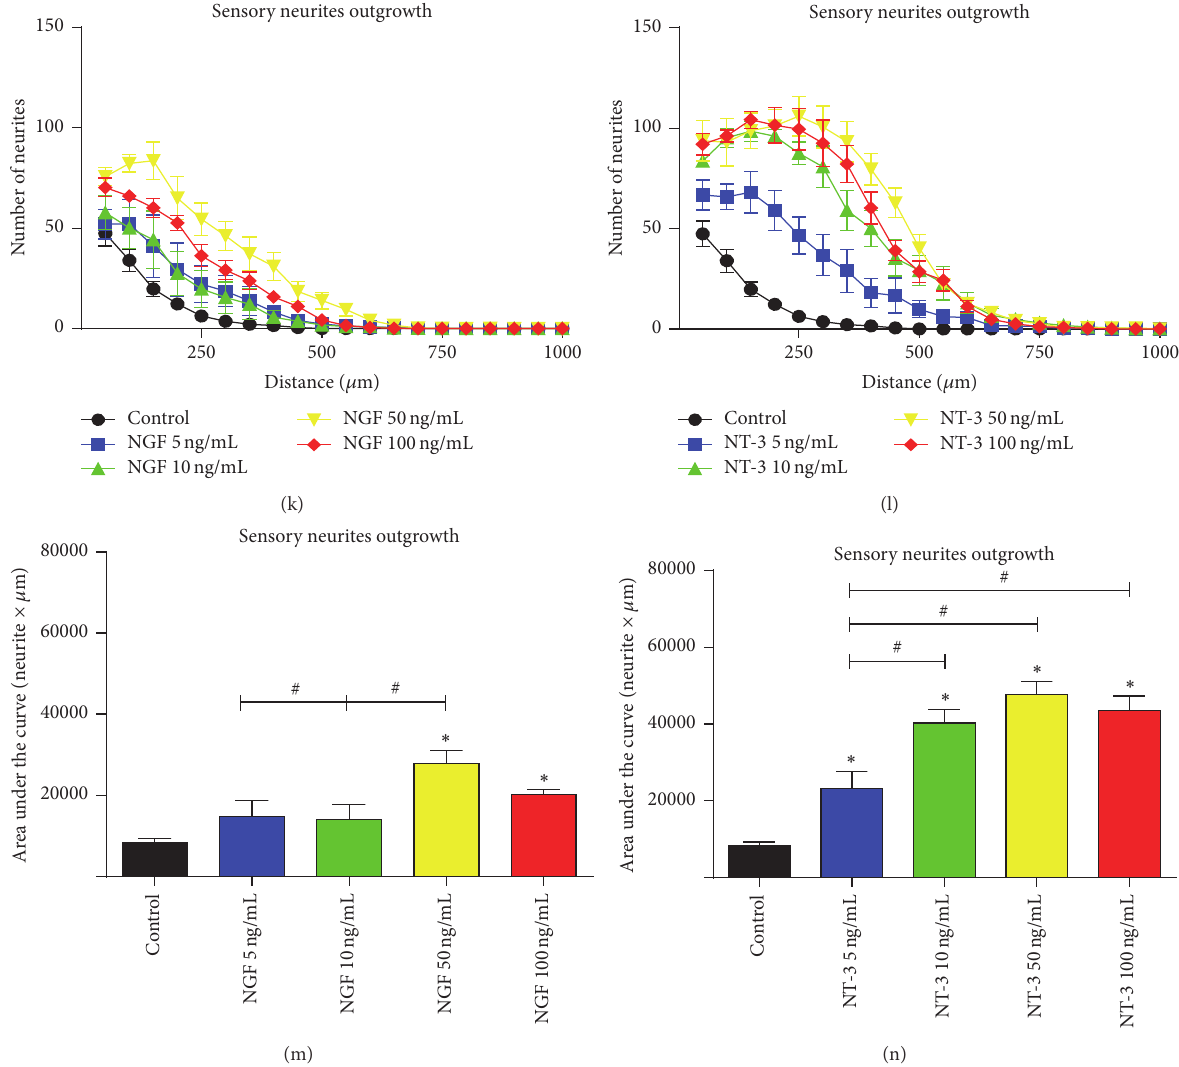
Figure 2: Representative images of RT97 stained neurites from spinal cord slices (a–c) and DRG neurons (d–f) cultured within a 3D collagen matrix alone (a, d) and with addition of 50 ng/mL of NGF (b, e) or NT-3 (c, f). Quantification of the number of neurites grown at increasing distance from the spinal cord slices (g, h) and from DRG body (k, l) after the addition of NGF and NT-3. Plots of the quantified AUC from (g), (h), (k), and (l) graphs for motor (i, j) or sensory (m, n) neurite outgrowth. Data expressed as mean ± SEM. ∗ 𝑝 < 0.05 versus control; # 𝑝 < 0.05 . Scale bar: 200 𝜇 m